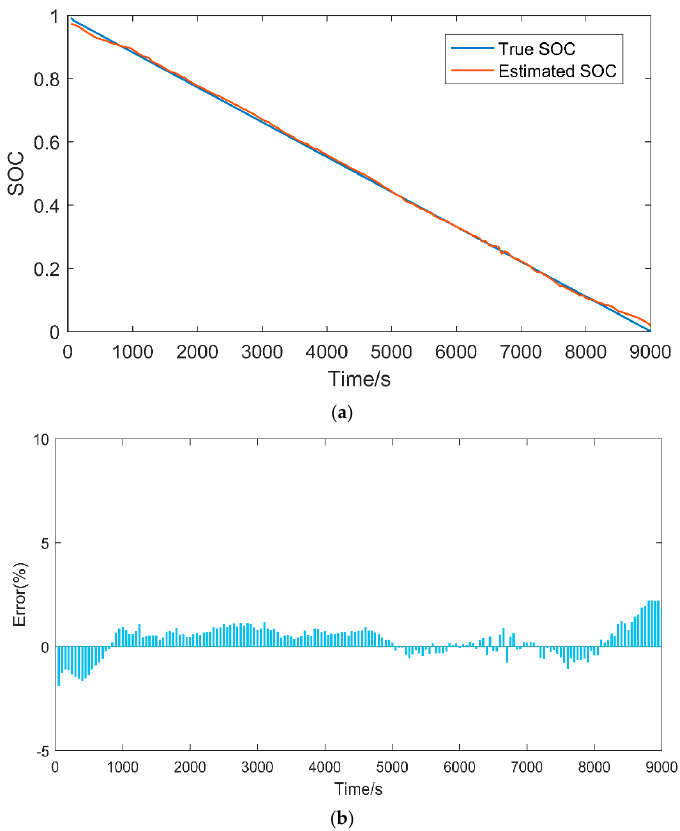
Figure 13. One-time half-cell SOC estimation results ( a ) and errors ( b ).